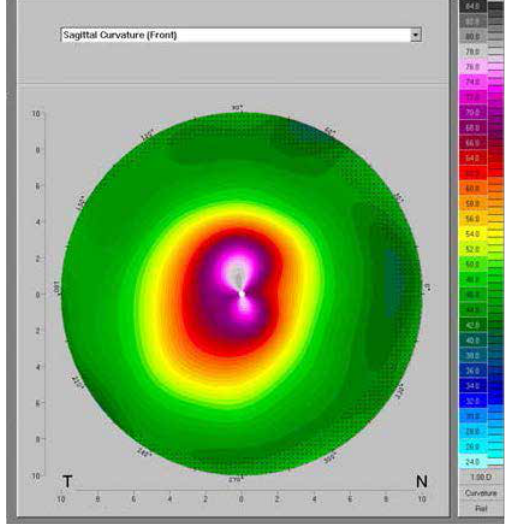
Figure 3 . A central cone is suggested in this Pentacam image.